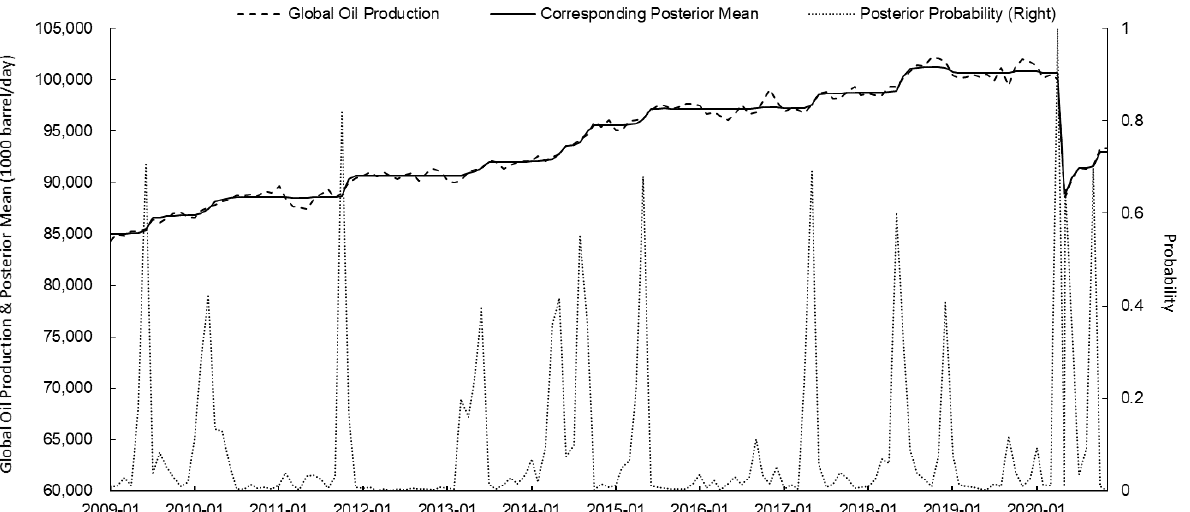
Figure 3. PPM calculation results of global oil production and corresponding posterior mean and posterior probability since 2009 (source: EIA).